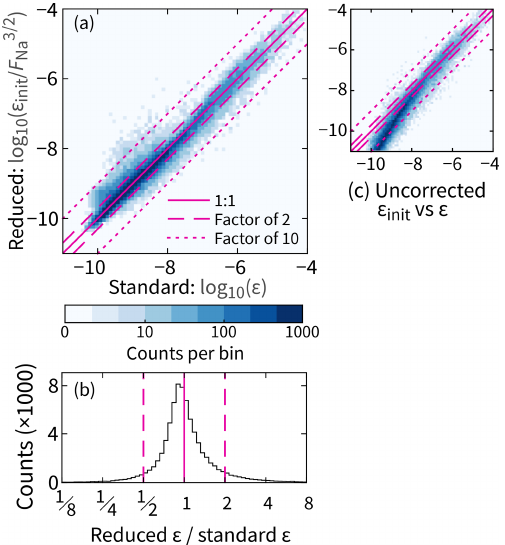
Figure 6. Statistical test of the proposed data reduction scheme for (cid:15) based on all 650 profiles (77000 segments). (a) A comparison that includes the dependence on (cid:15) . (b) Further summarized data that exclude this dependence. (c) Same as for panel (a) but uncorrected ( F Na =